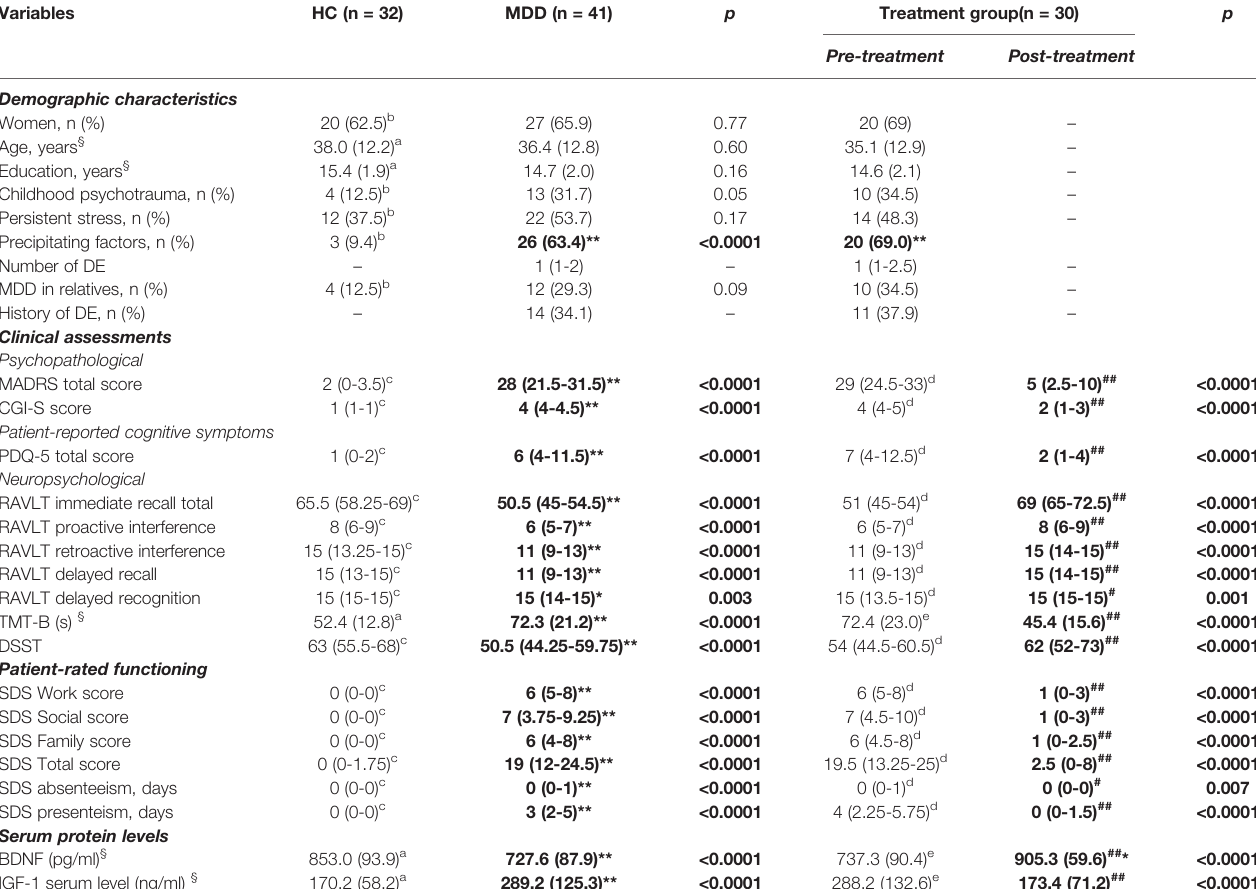
TABLE 1 | Demographic, psychopathological, neuropsychological, functional characteristics, and serum BDNF and IGF-1 levels in healthy controls and MDD patients.